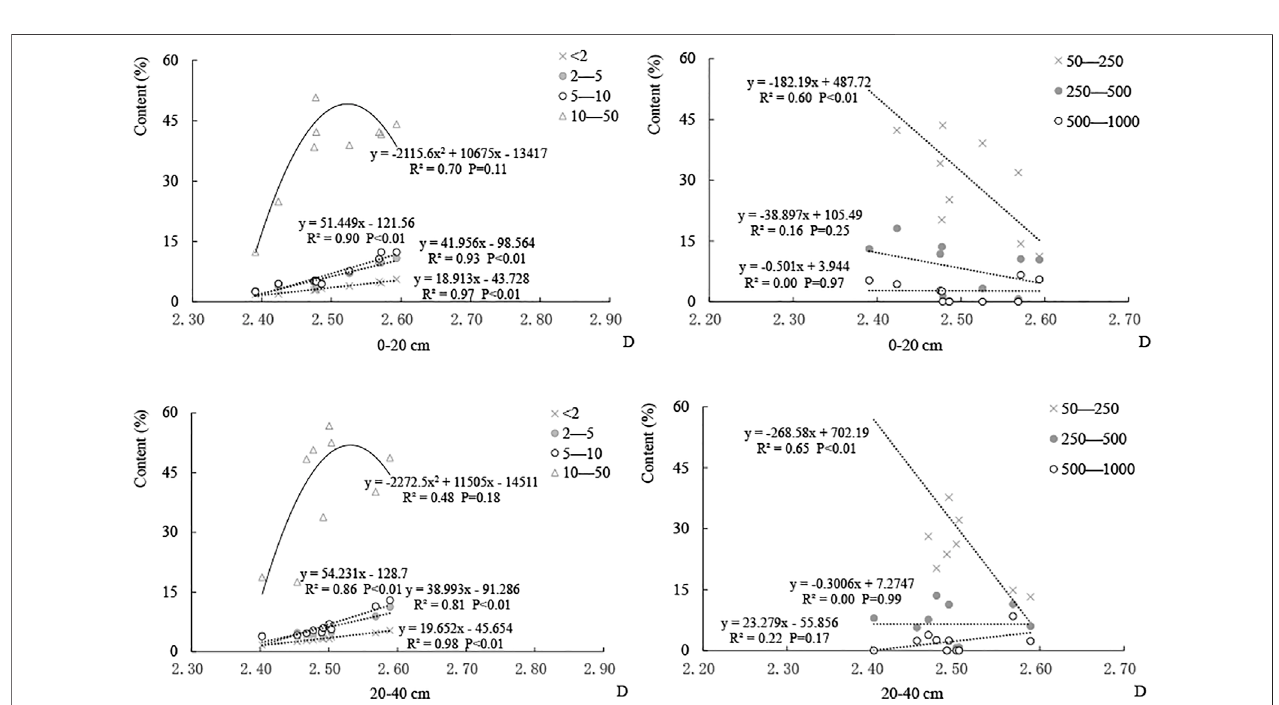
FIGURE 5 | Content relationship between D and the particle size in the woodland (NW) in the non fl ooded area.